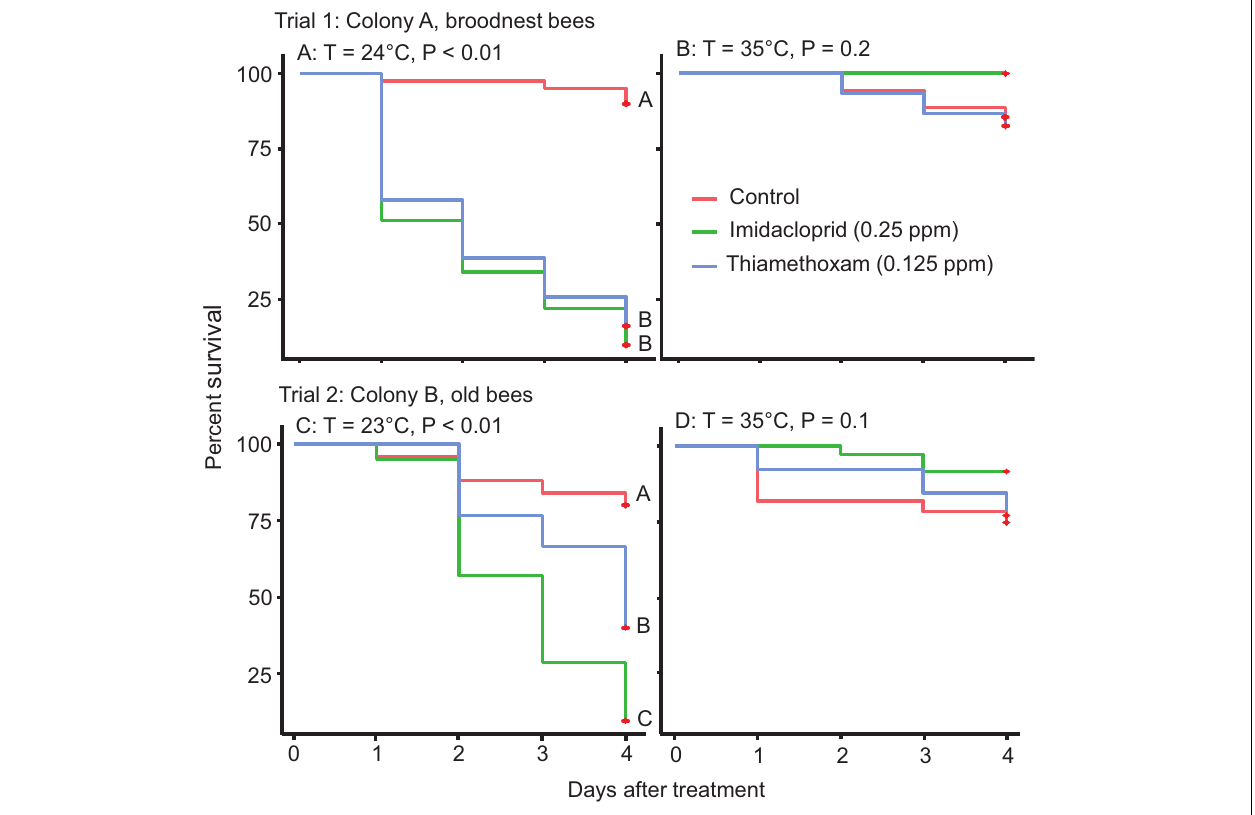
FIGURE 1 | Results of Trials 1 and 2 showing Kaplan–Meier survival curves of bees fed with imidacloprid or thiamethoxam or sugar only (control) at 23/24 at 24 ◦ C ( left , A , C ) or 35 ◦ C ( right , B , D ). Different letters at each line indicate significant differences with Log Rank tests at P < 0.05.